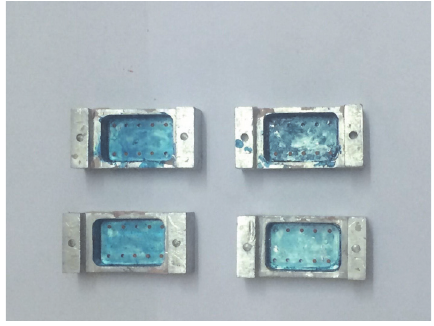
Figure 1: Stainless steel master cast used in the study. Figure 2: Aluminum impression trays used in the study.